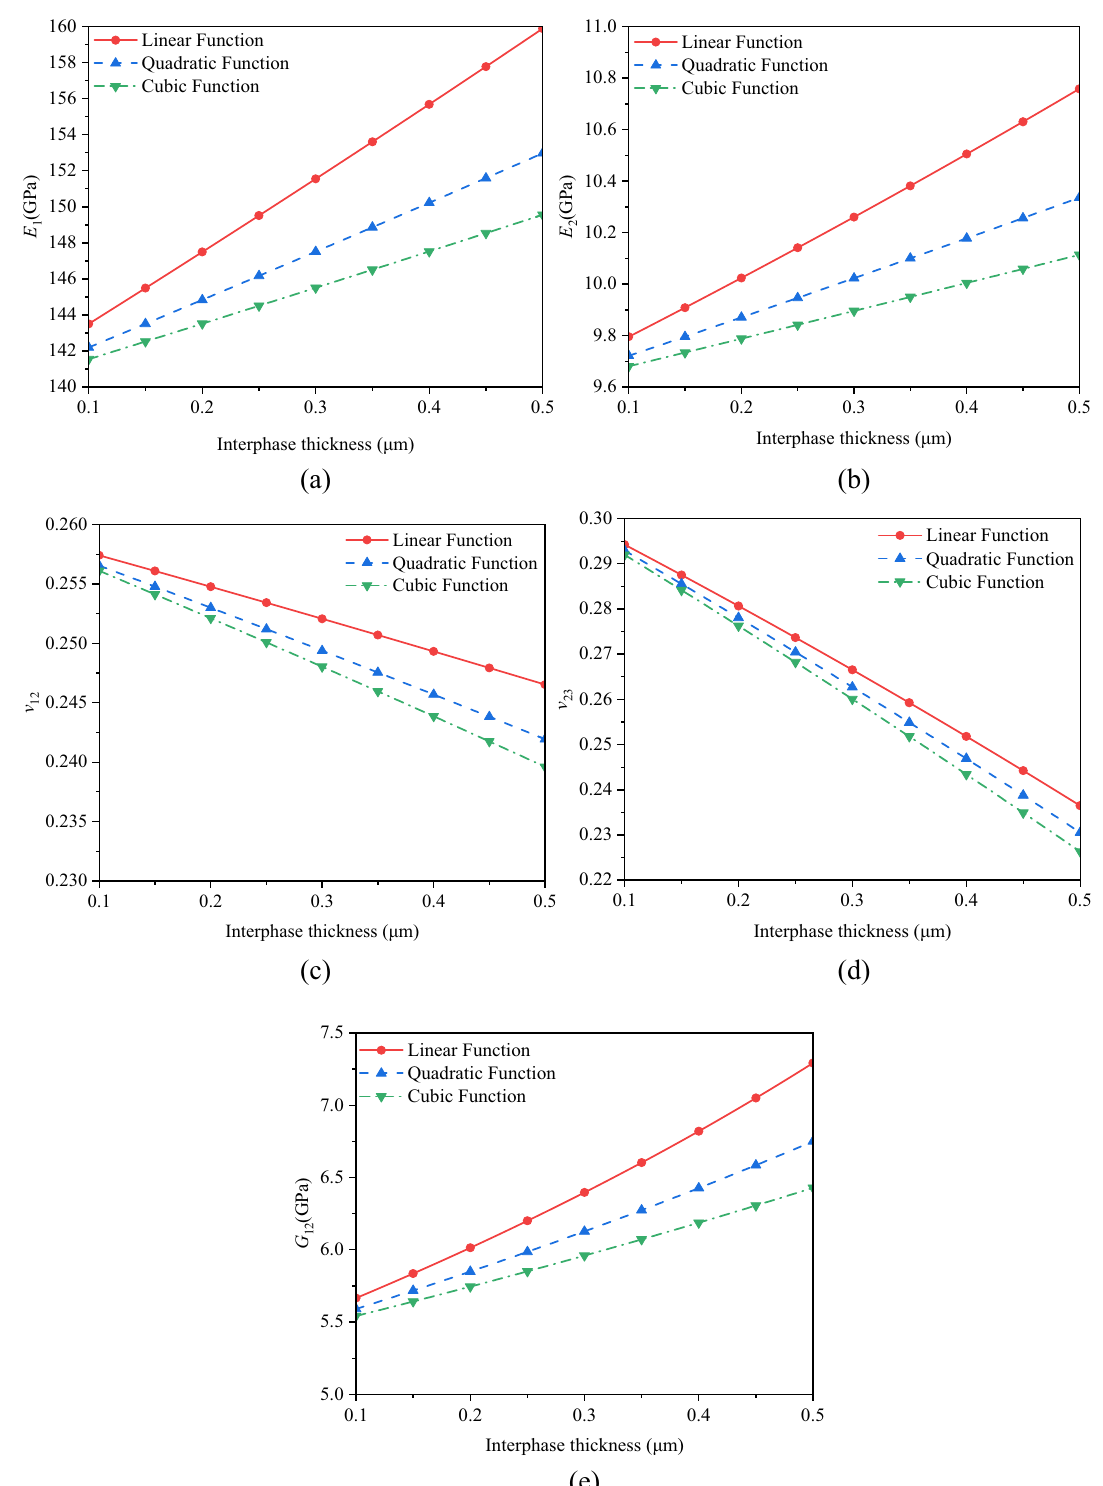
Figure 15: E ff ect of interphase thickness on composite properties with di ff erent interphase mechanical property gradients: ( a ) elastic modulus E 1 , ( b ) elastic modulus E 2 , ( c ) Poisson ’ s ratio ν 12 , ( d ) Poisson ’ s ratio ν 23 , and ( e ) shear modulus G 12